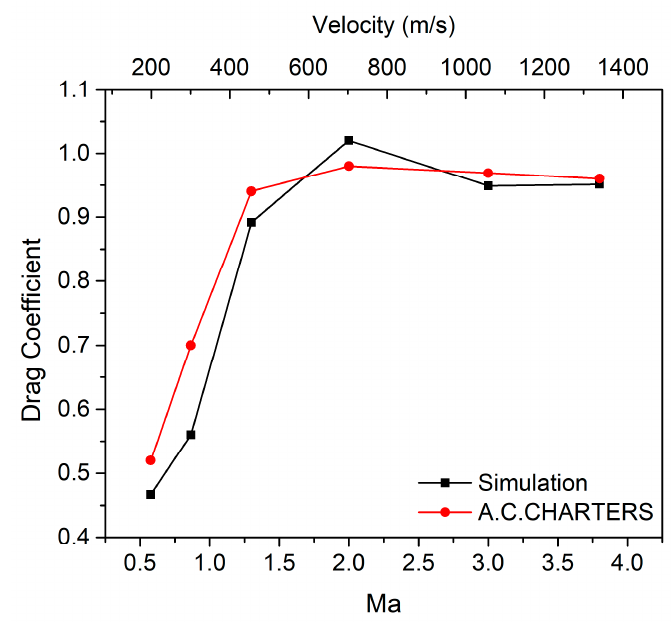
Figure5. Comparisonofdragcoe ffi cientsbetweenthe2Daxisymmetricsimulationandtheexperimental Figure 5. Comparison of drag coefficients between the 2D axisymmetric simulation and the data for a 14.28-mm sphere reported by Charters and Thomas experimental data for a 14.28-mm sphere reported by Charters and Thomas [26].